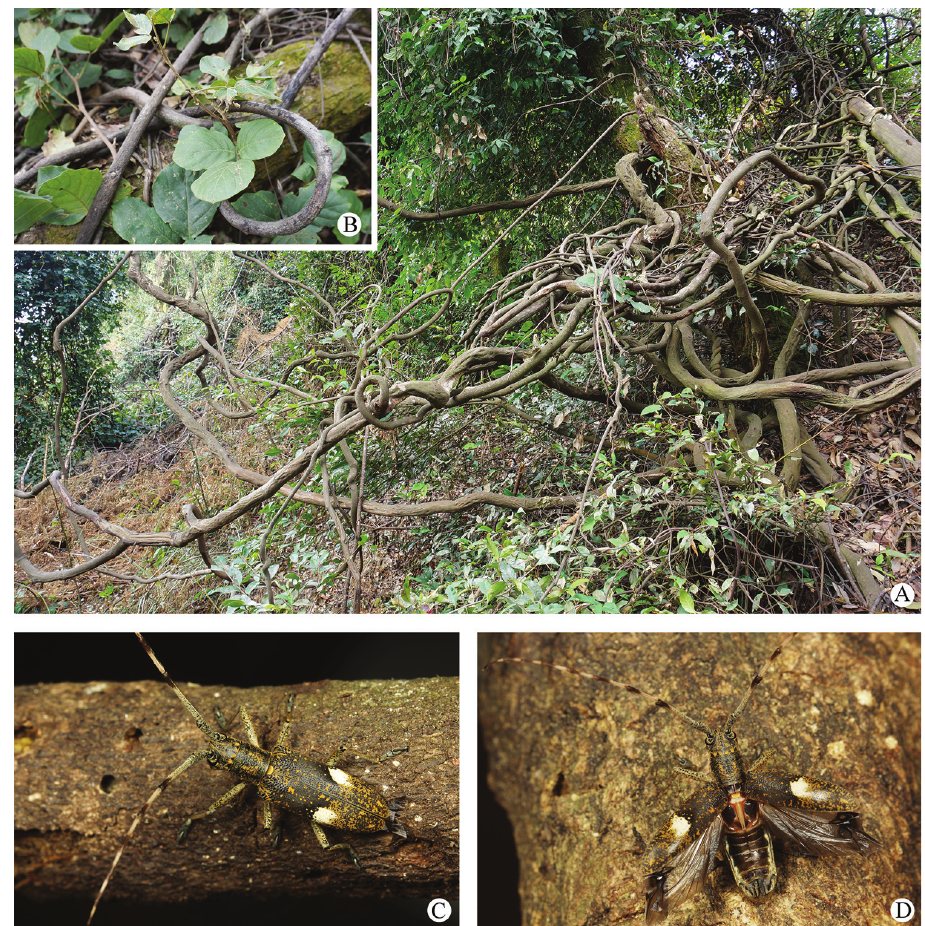
Figure 6. Field observations of Pseudomacrochenus wusuae sp. n. A biotope B host plant Craspedolobium schochii Harms C adult (resting) D adult (preparing to